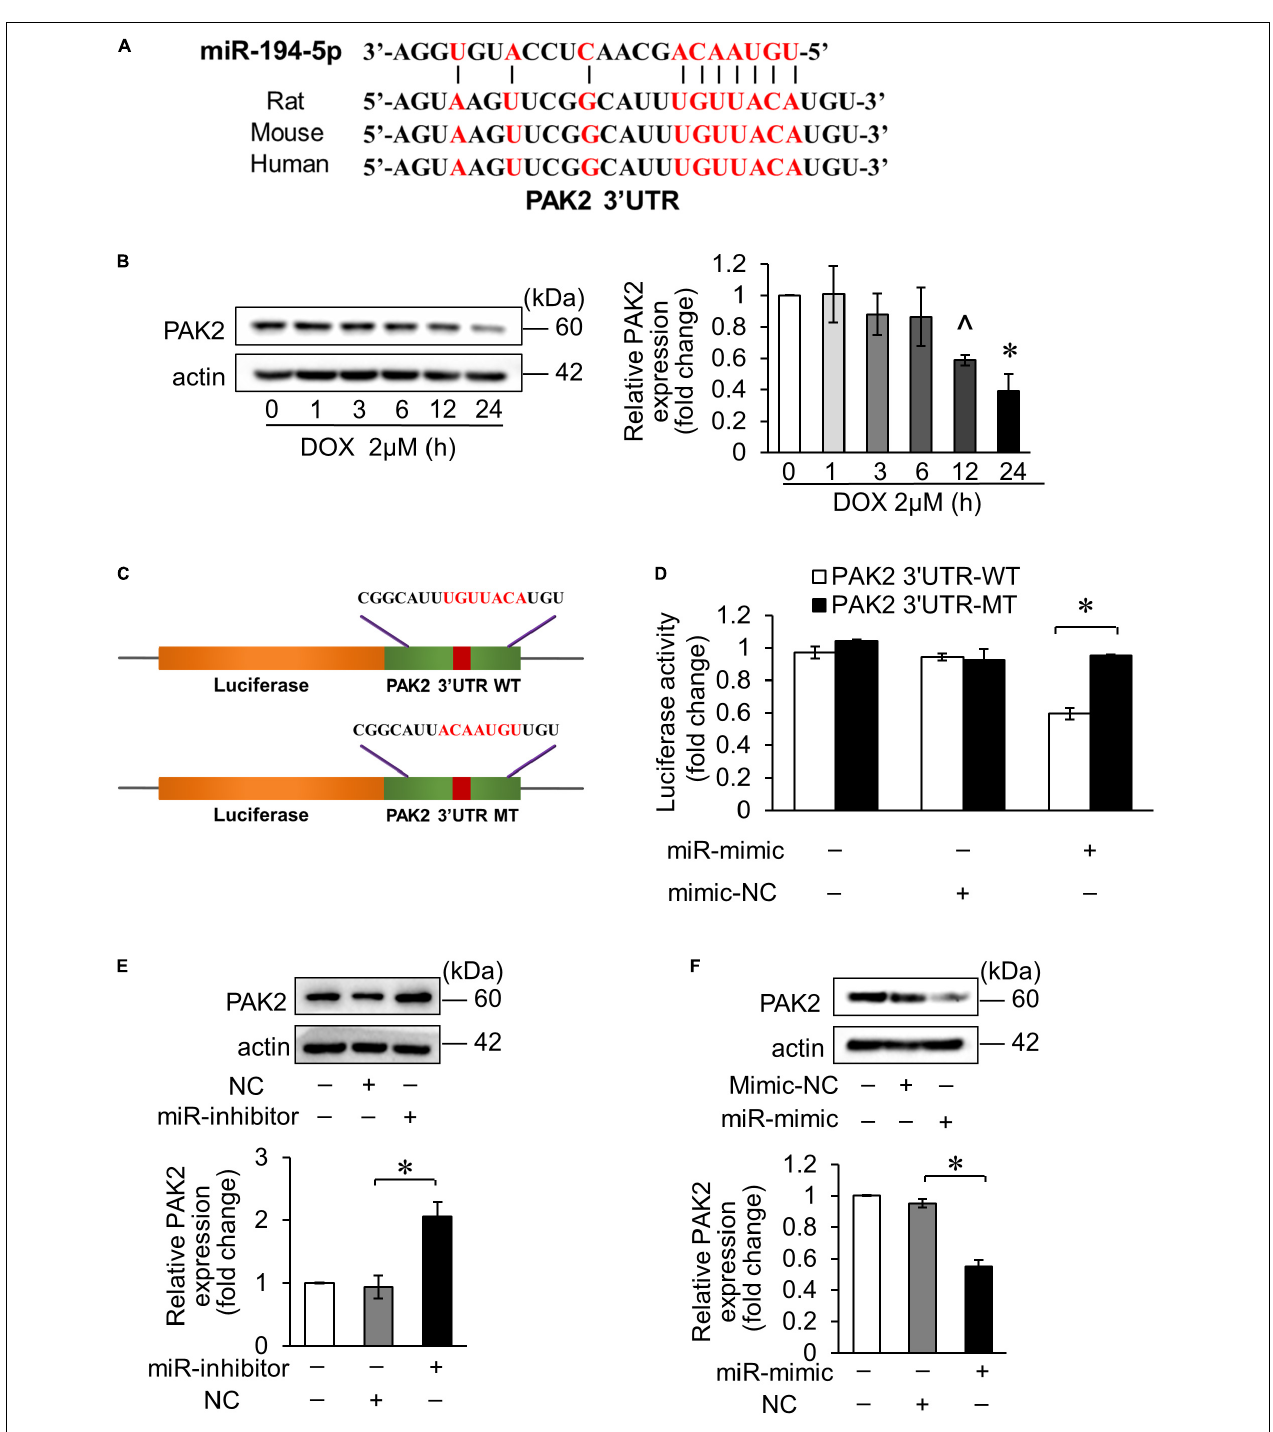
FIGURE 2 | MiR-194-5p directly targeted PAK2. (A) Prediction of the PAK2 3 (cid:48) UTR potential binding site of miR-194-5p via bioinformatics program TargetScan. Potential complementary bases are shown in red. (B) H9c2 were treated with 2 µ M DOX for the indicated times. The expression levels of PAK2 were detected by Western blots and the quantitative histogram was shown. ∧ p < 0.05 vs. control. ∗ p < 0.01 vs. control. (C) Schematic diagram of the reporter containing the putative miR-194-5p binding site in the PAK2 3 (cid:48) UTR region. WT, wild-type; MT, mutant. (D) Luciferase activity detected in HEK-293 cells transfected with miR-194-5p mimic or negative control along with luciferase reporter constructs, as indicated. (E) H9c2 was transfected with miR-194-5p inhibitor for 24 h. The expression levels of PAK2 were detected by Western blot and the quantitative histogram was shown. (F) H9c2 was transfected with miR-194-5p mimic for 24 h. The expression levels of PAK2 were detected by Western blot and the quantitative histogram was shown. All the experiments have been performed independently in triplicate, and the data were expressed as mean ± SD. ∗ p < 0.01 as indicated.